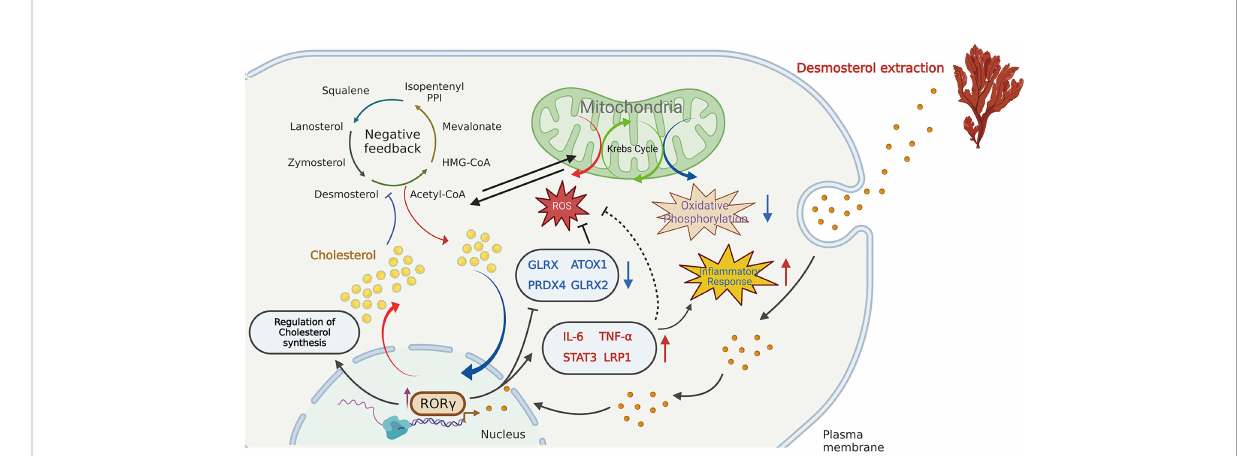
FIGURE 4 Schematic illustration of the DES-mediated transcriptional regulation in cholesterol biosynthesis, pro-in fl ammatory and oxidative stress. DES causes the highly expressed ROR g in the IPI-2I and facilitates cholesterol production. The increased cholesterol inhibits the endogenous cholesterol de novo synthesis in a negative feedback loop. Again, DES exerts anti- oxidative effects by downregulating oxidative stress- regulated gene expression ( GLRX , PRDX4 , ATOX1 , GLRX2 , etc.). Moreover, DES also upregulated the expression of in fl ammation-related genes ( IL-6 , TNF- a , STAT3 , LRP1 , etc.) to activate the immune